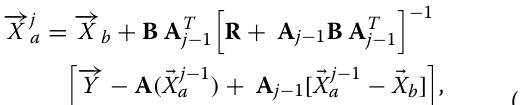
Table 1 Ionosonde stations used in analysis